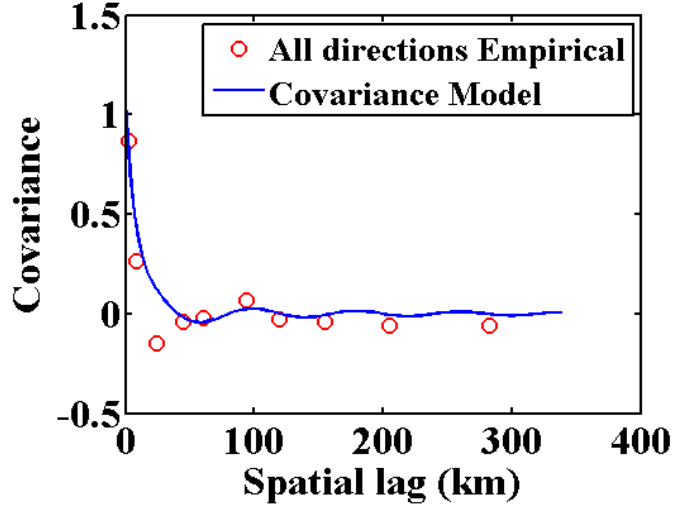
Figure 7. Observed (red circles) and modeled covariance of the O 3 residual concentrations on a one-year time scale shown as a function of spatial lag in BME.